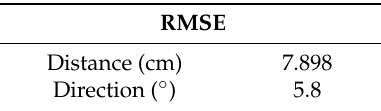
Table 4. RMSE of distance and direction.